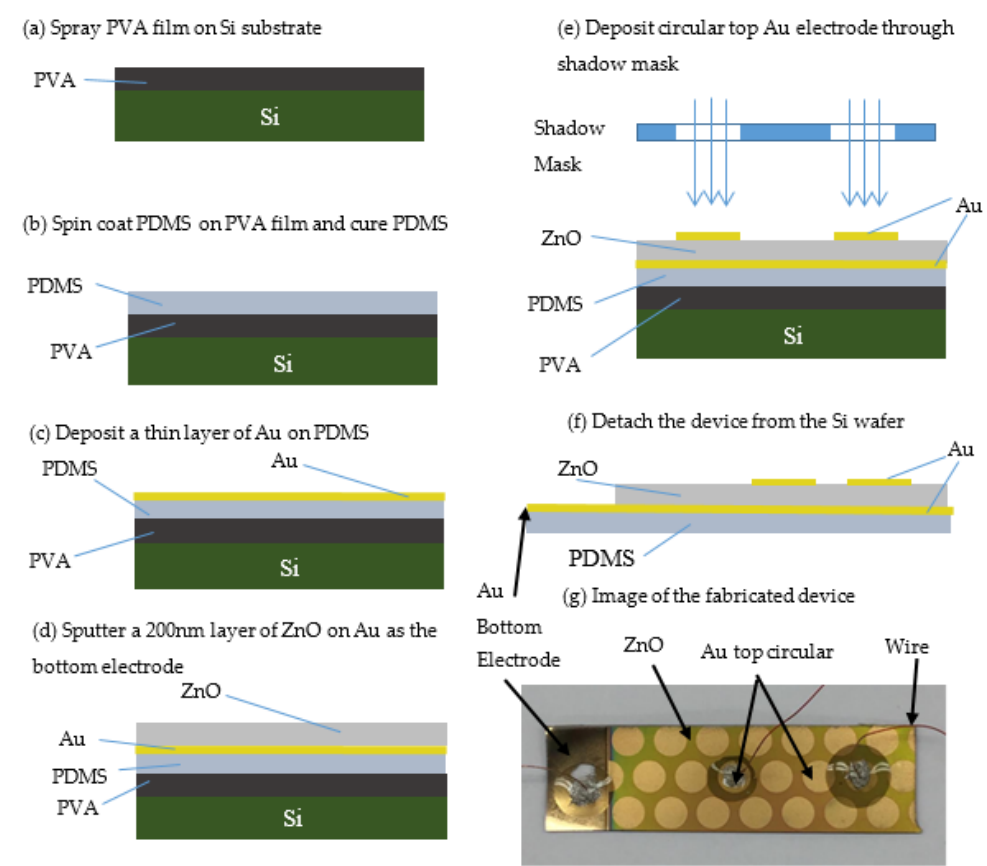
Figure 2. Illustration of the fabrication steps required for the power generator. ( a ) Spray polyvinyl alcohol (PVA) on a Si substrate. ( b ) Fabricate a layer of poly(dimethylsiloxane) (PDMS) on the PVA. ( c ) Deposit the bottom Au electrode for power harvesting on the PDMS. ( d ) Sputter ZnO on Au electrode. ( e ) Deposit circular Au electrodes on top of ZnO using a shadow mask. ( f ) Detach the power generator from the Si wafer by solving PVA film in water. ( g ) Photograph of the fabricated device.